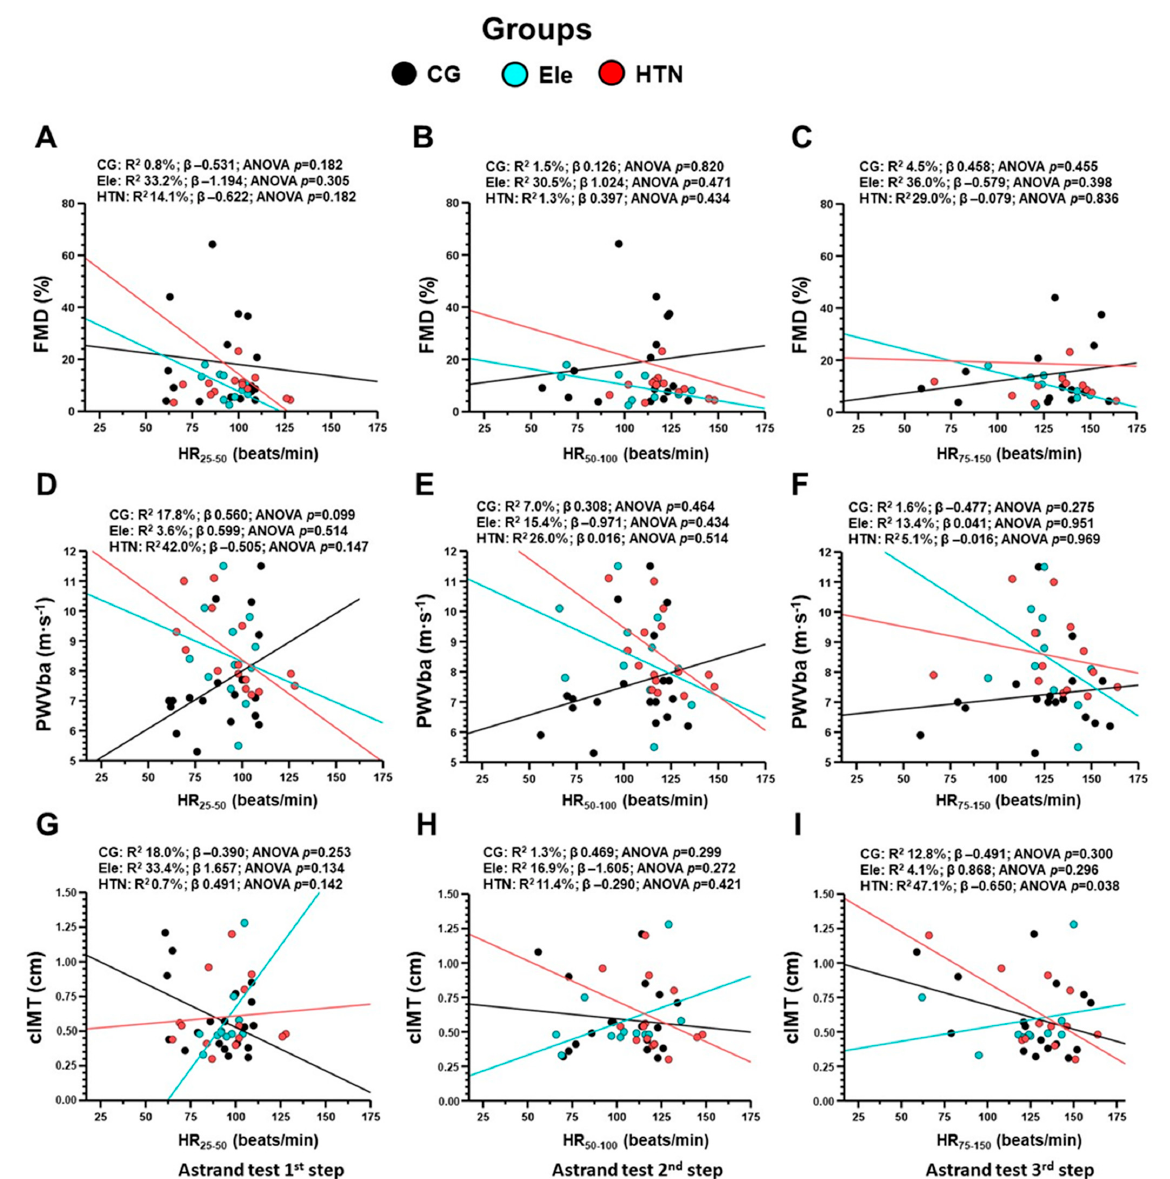
Figure 6. Association (by linear regression) between vascular parameters flow-mediated dilation (panels A – C ), pulse wave velocity of the brachial artery (panels D – F ), and carotid intima-media thickness (panels G – I ) with heart rate at the first HR 25–50 (panels A , D , G ), second HR 50–100 (panels B , E , H ), and the third HR 75–150 (panels C , F , I ). Groups are described as: CG: Control normotensive group, Ele: Elevated blood pressure, and the HTN: arterial hypertension group. FMD: Flow-mediated dilation in %. PWVba: Pulse wave velocity of the brachial artery, and cIMT):Carotid intima-media